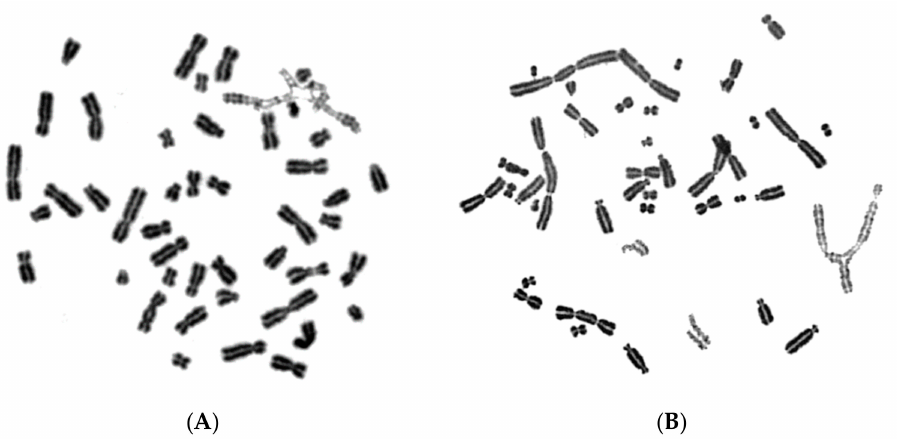
Figure 6. Aberrant chromosomes entrapped in MN can be duplicated. If entrance of main nuclei into mitosis is su ffi ciently delayed by RO-3306, radiation-induced aberrant anaphase lagging chromosomes entrapped in MN can also undergo chromatid disjunction and complete DNA replication, without any apparent chromosome shattering. ( A ) Duplication of aberrant chromosome 1 (lightly stained) entrapped in MN following radiation exposure (4 Gy) of human G 0 -lymphocytes. ( B ) Duplication of aberrant anaphase lagging chromosomes (lightly stained) entrapped in MN following 4 Gy exposure of G 0